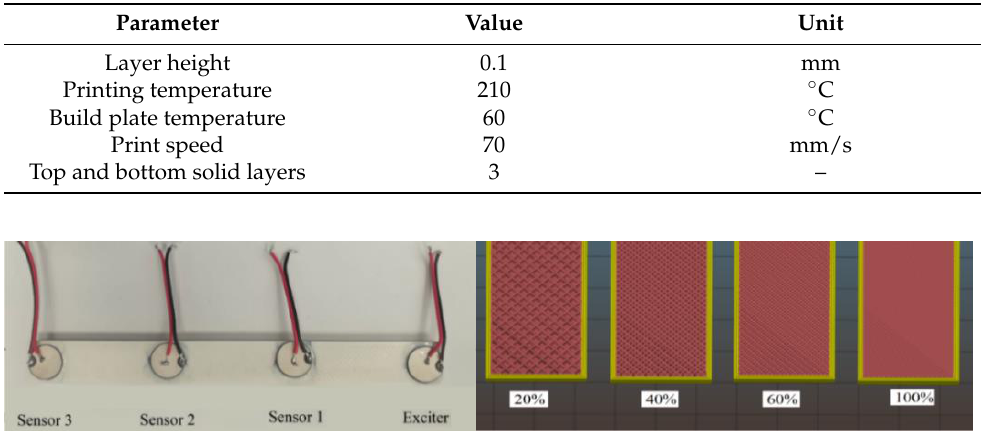
Figure 1. 3D printed part ( left ), and infill density of different parts ( right ).